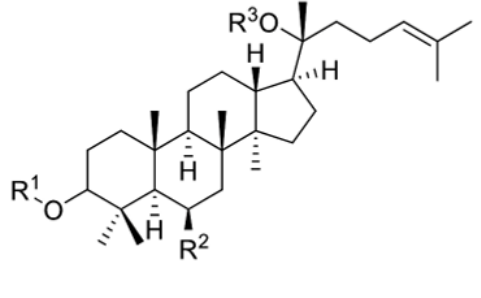
FIGURE 1: General structure of the saponin. Saponins are glu- cosides with foaming characteristics. Saponins consist of a polycyclic aglycones attached to one or more sugar side chains. The aglycone part, which is also called sapogenin, is either a steroid (C 27 ) or a triterpene (C 30 ). The foaming ability of sapo- nins is caused by the combination of a hydrophobic (fat- soluble) sapogenin and a hydrophilic (water-soluble) sugar part (R 1 , R 2 , R 3 : -sugar or -H